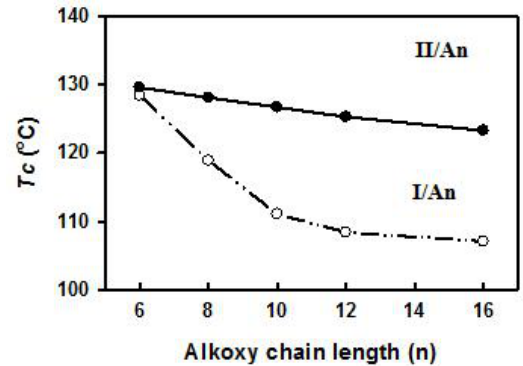
) and II / An ( • ) in thermal mesophase Figure 6. Comparison between SMHB complexes I/An ( ○ ) and II/An (●) in thermal mesophase stability. (cid:35)